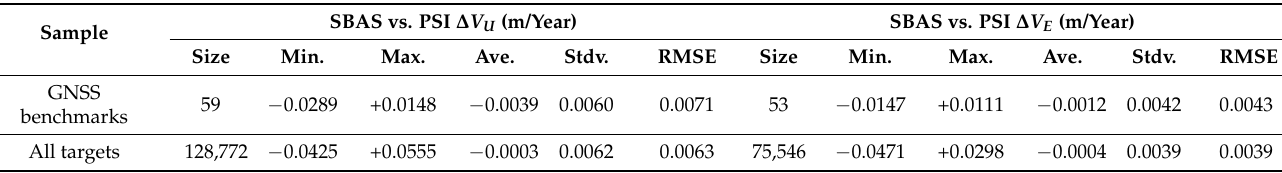
Table 1. PSI-SBAS inter-comparison: observed difference in vertical ∆ V U and east-west ∆ V E velocity estimated from the PSI and SBAS InSAR analyses. The size indicates the number of targets used for comparison, which depends on the coverage of the output datasets. Notation: min., minimum; max., maximum; ave., average; stdv., standard deviation; RMSE, root mean square